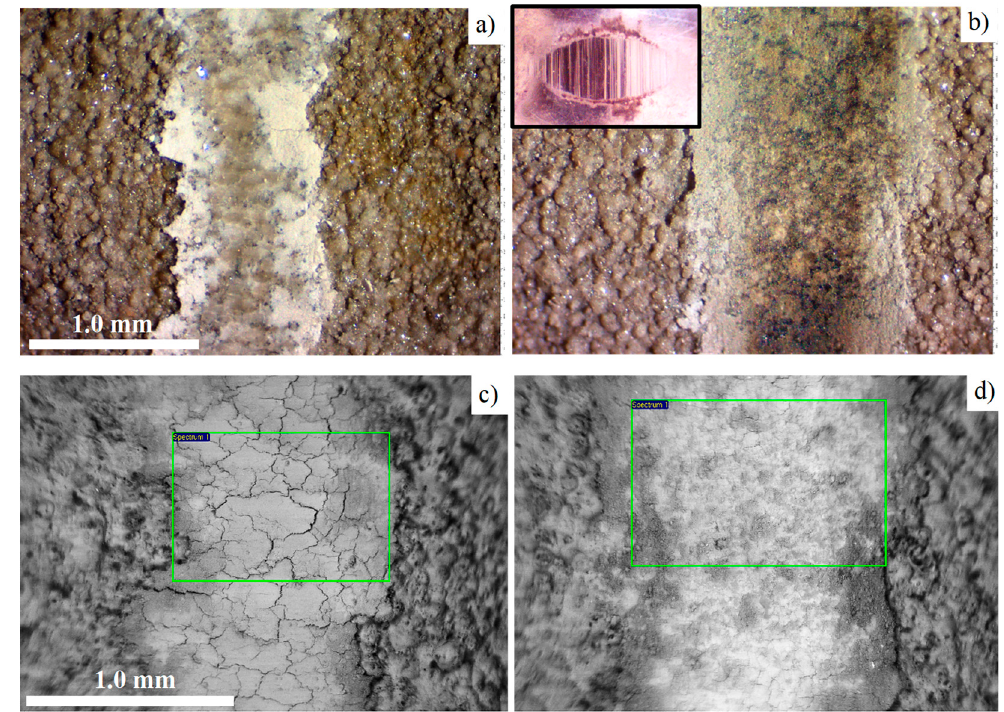
Figure 10. Wear scars on the PEO coating taken by optical microscopy ( a , b ) and by SEM BSE imaging ( c , d ) after wear tests against different counterfaces, as follows: ( a , c ) WC-4%Co and ( b , d ) bearing steel. Inset in ( b ) shows the bearing steel ball the surface after test. The rectangles on ( c , d ) designate the areas of the EDS analysis shown in Table 3.